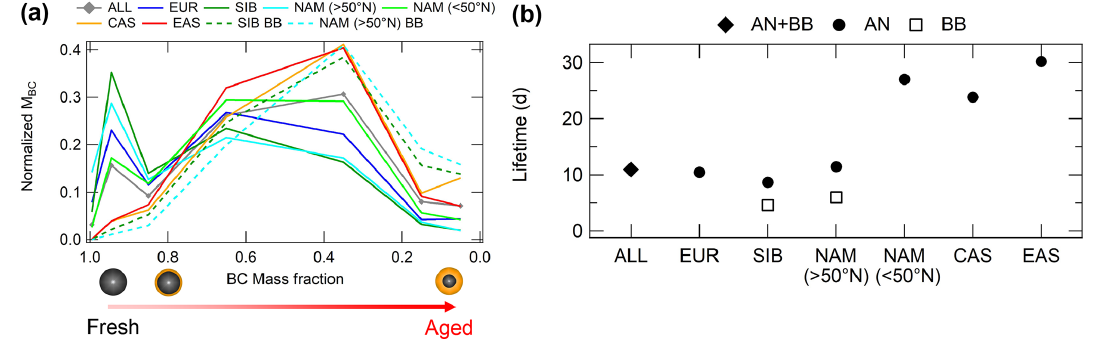
Figure 12. (a) BC mixing state distributions for total BC mass (ALL) and for BC mass from the eight major sources (six anthropogenic (AN) sources and two biomass burning (BB) sources). BC particles are gradually shifted from the left (fresh BC with a lower MAC BC ) to the right (aged BC with a higher MAC BC ) by aging processes in the atmosphere. (b) Lifetimes in the Arctic for total BC (ALL) and for BC from eight major sources. Lifetimes were defined by the ratio of BC deposition flux to atmospheric BC loading in the